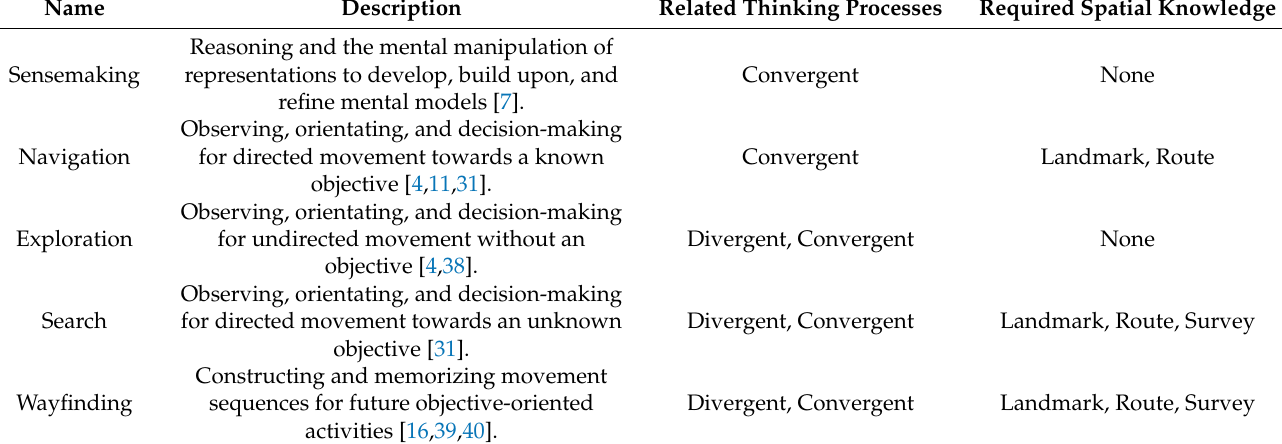
Table 1. Summary of the cognitive activities performed within spaces. Included is the name and description, the underlying processes of creative thinking which relate to the cognitive activity, and the types of spatial knowledge which must be developed within a cognitive map of a space before the activity can be performed within that